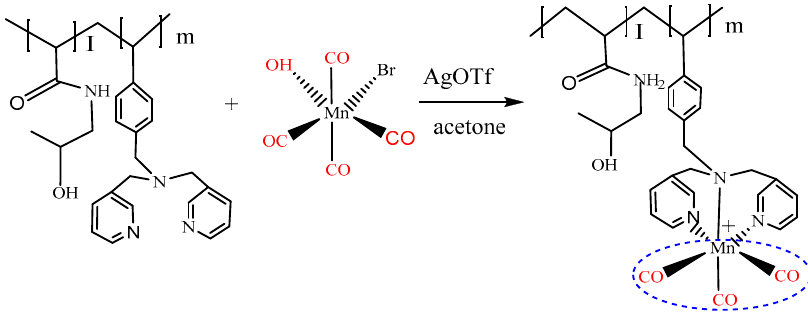
Figure 21. The copolymer P1 synthesized for releasing CO segment.